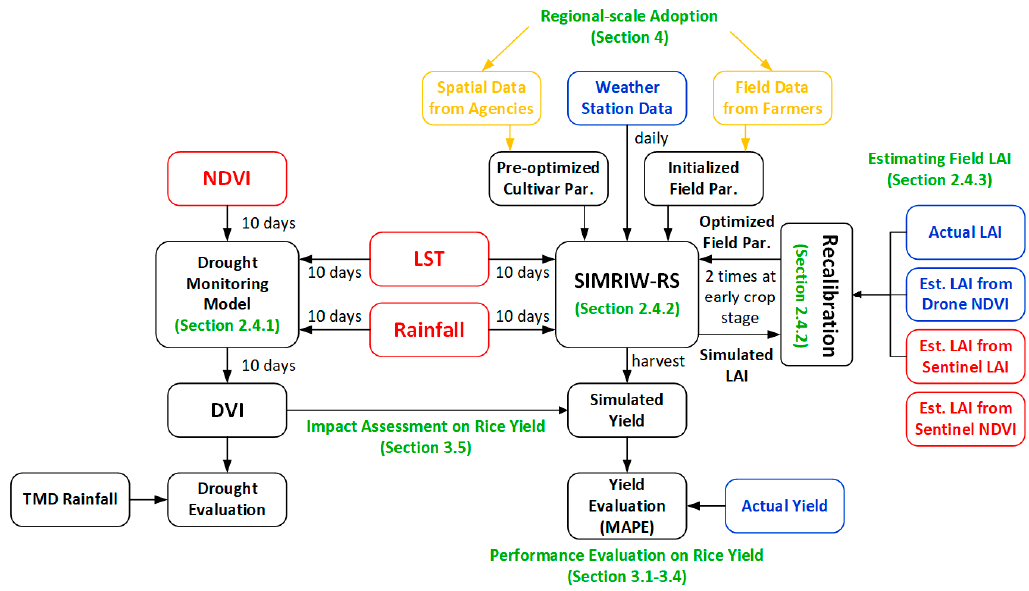
Figure 1. Research methodology and data sources used in this study. See text for full details.